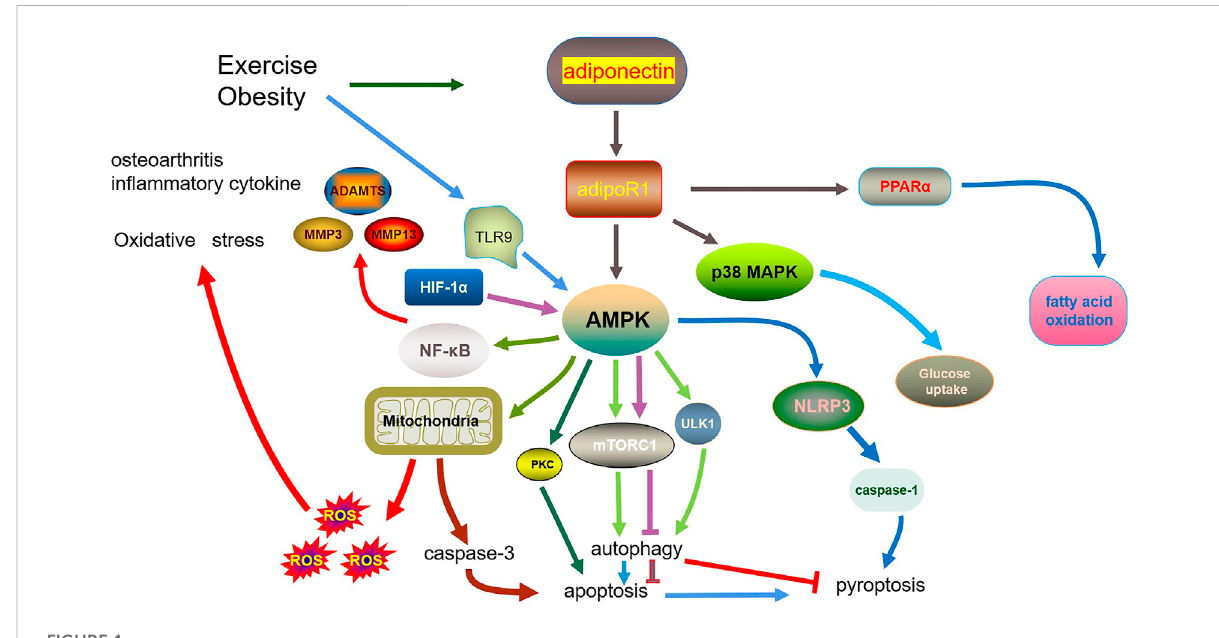
FIGURE 1 Role of adiponectin in